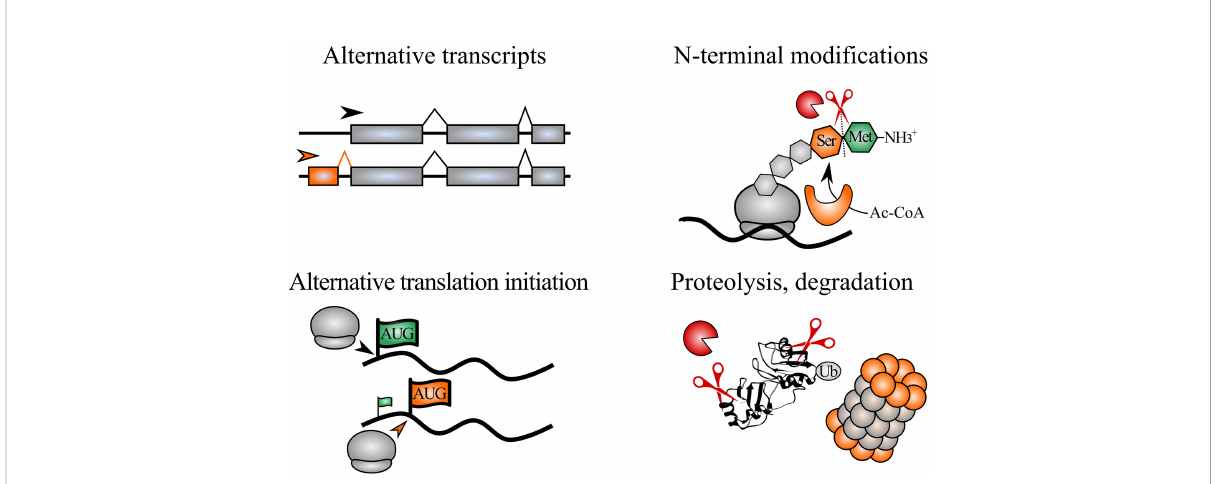
FIGURE 1 Biological processes shaping distinct N-terminal proteoforms. Expression of alternative transcripts with differing exon-intron structures can encode novel protein N-termini. Alternative translation initiation sites can be selected, thereby shaping truncated and extended N-terminal proteoforms. During translation, initiator Met (green) can be cleaved by Met aminopeptidases, exposing the second residue (here Ser, orange). In addition, protein N-termini can be N-terminally modi fi ed, e.g. such as co-translational N-terminal acetylation catalyzed by N-terminal acetyltransferases. Lastly, post-translational cleavage of proteins by proteases yields proteolytic fragments that can acquire novel functions or be further degraded, e.g. via the ubiquitin proteasome pathway. Ac-CoA, acetyl coenzyme A; Ub,